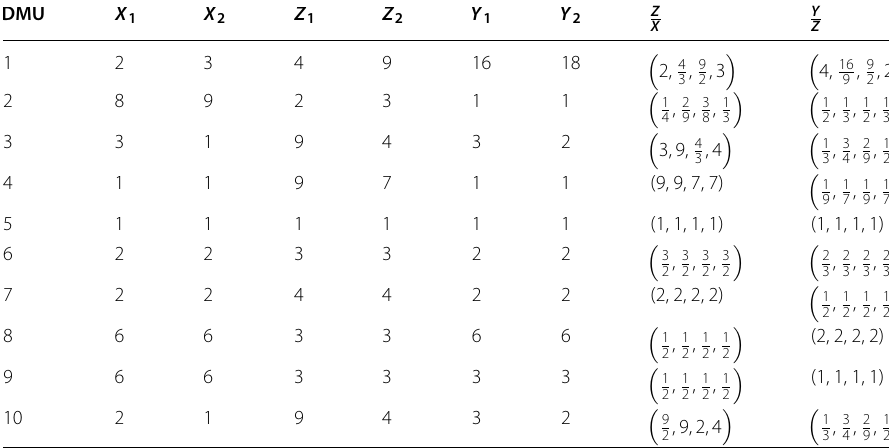
Table 3 Example 2. Data set for 10 two-stage DMUs